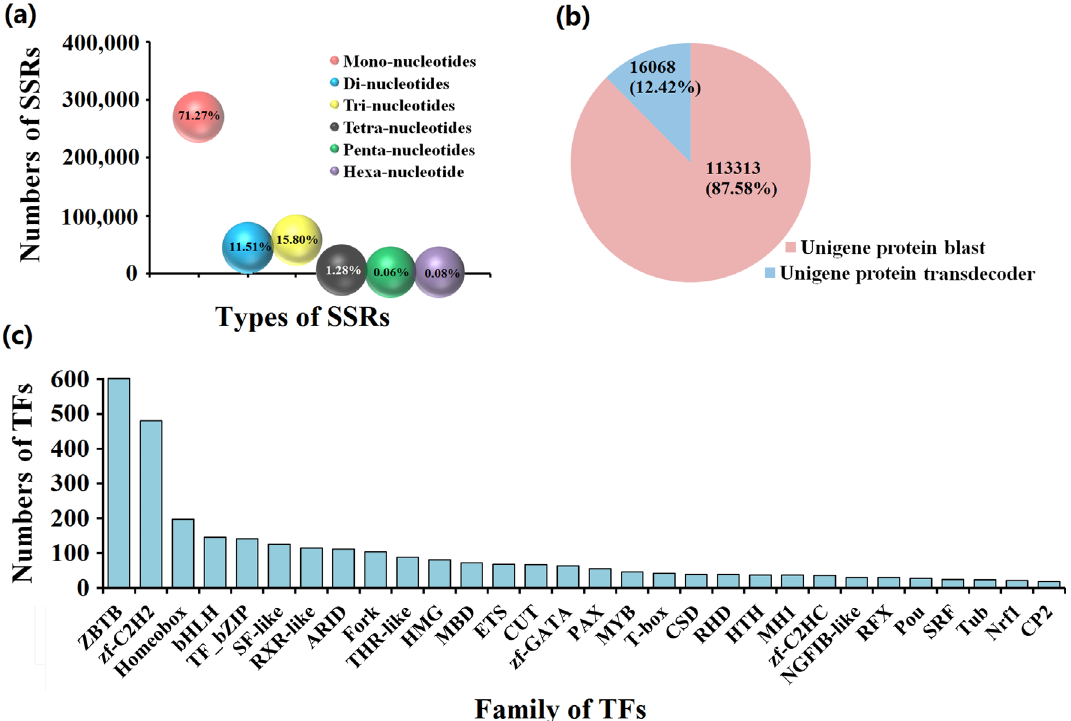
Figure 3. Analysis and prediction of simple sequence repeats, open reading frames, and transcription factors. (a) Simple sequence repeats of M. pallidipes transcripts. Number of bases repeated is on the x -axis and amount of sequence repeats is on the y -axis. (b) Analysis of open reading frames (ORF). Red, ORFs annotated by NR and SwissProt; blue, ORFs predicted using Transdecoder. (c) Transcription factors predicted using SMRT. Transcription-factor family is on the x -axis and number of transcription factors is on the y -axis.